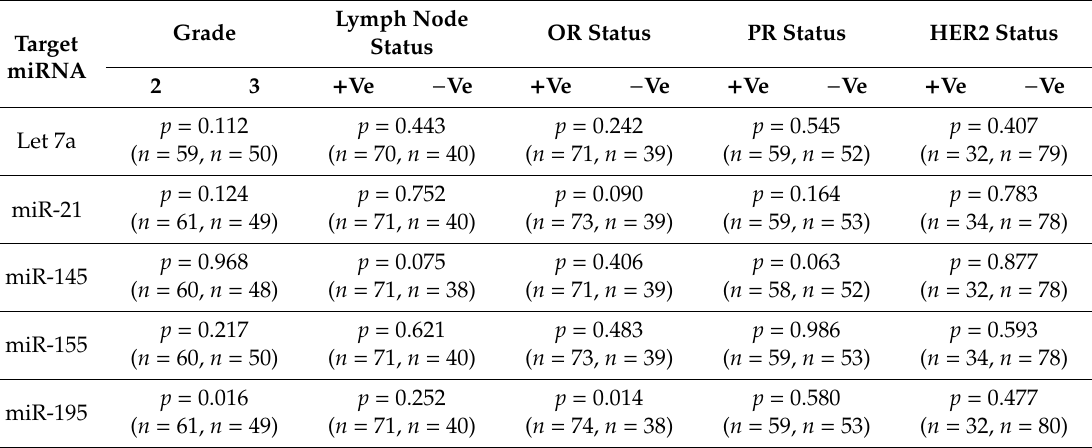
Table 3. Relationship of target miRNA on clinicopathological details.